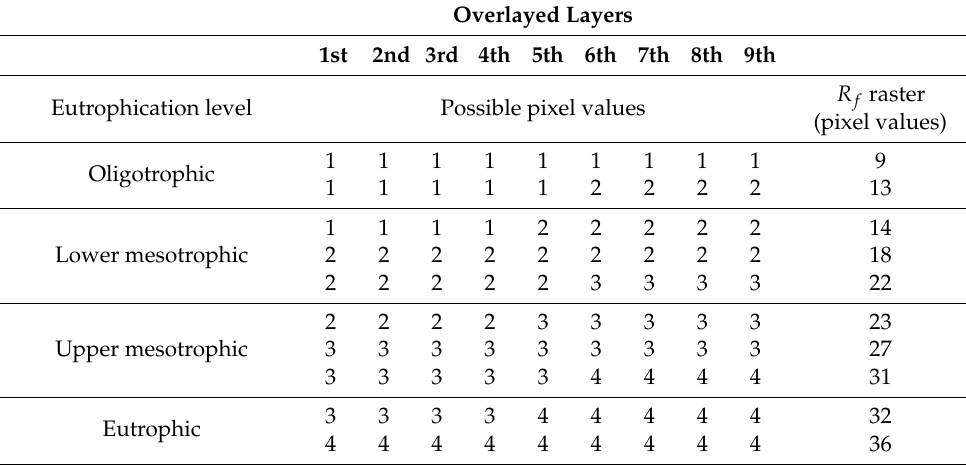
Table 3. Eutrophication scale for the classification of the pixel values of the R f raster that is the result of the integration of the three variables when weights are assigned to them.